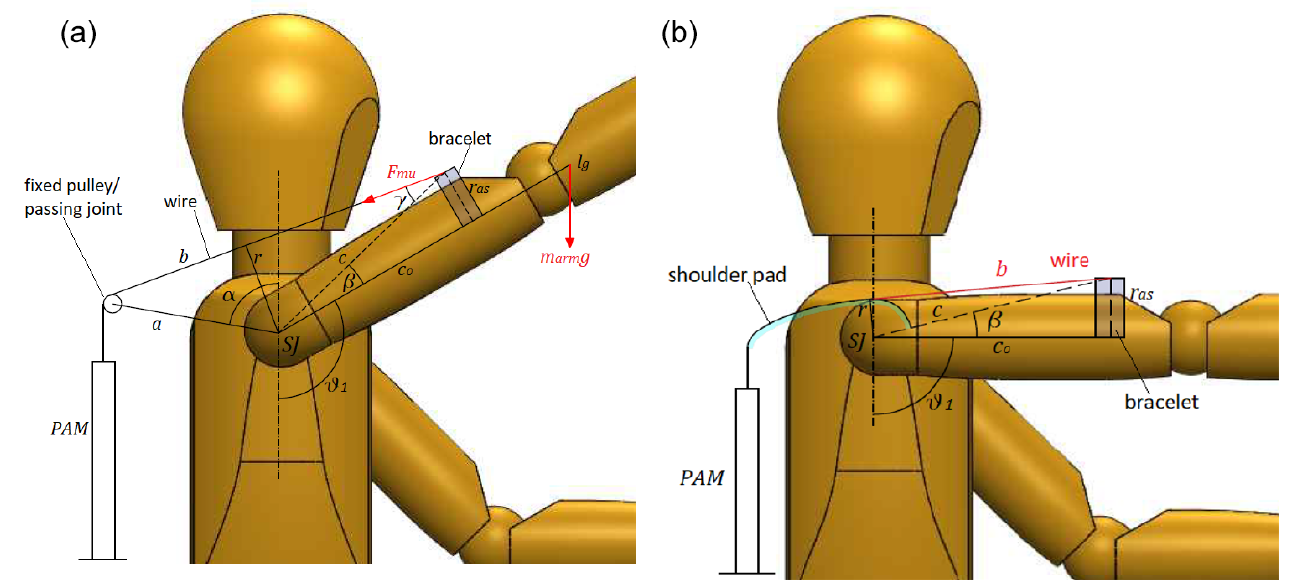
Figure 3. Different designs of the exoskeleton: pulley-based design (a) and cam-based design (b) .